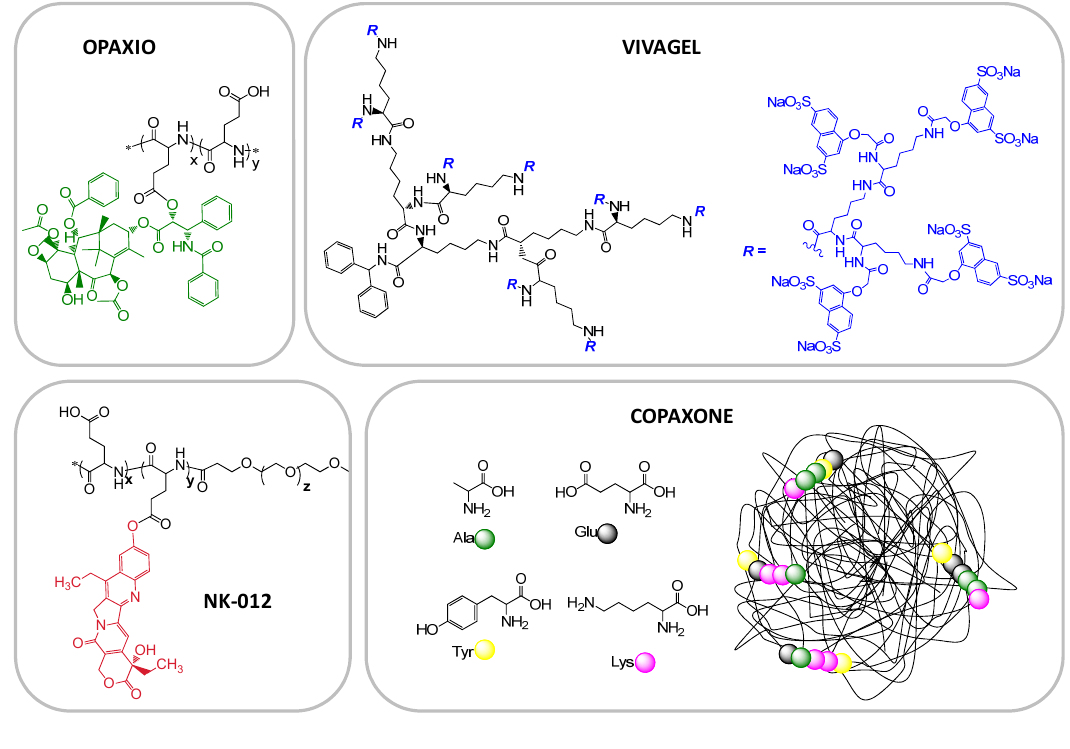
Figure 6. Examples of polypeptide-based polymer therapeutics in the